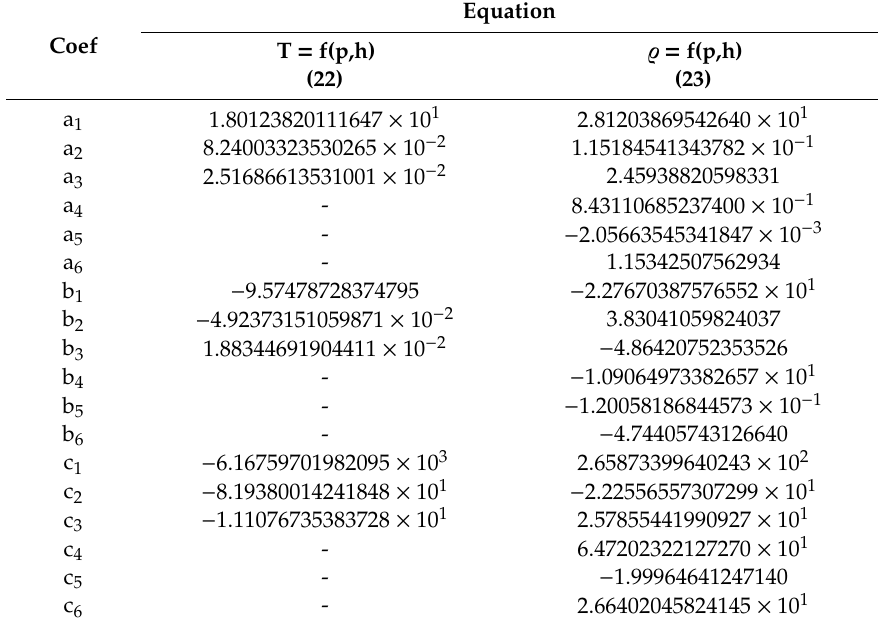
Table 9. Coe ffi cients of polynomials describing the properties of the R1234ze(E) refrigerant in the superheated vapour state (T = f(p,h), (cid:37) =